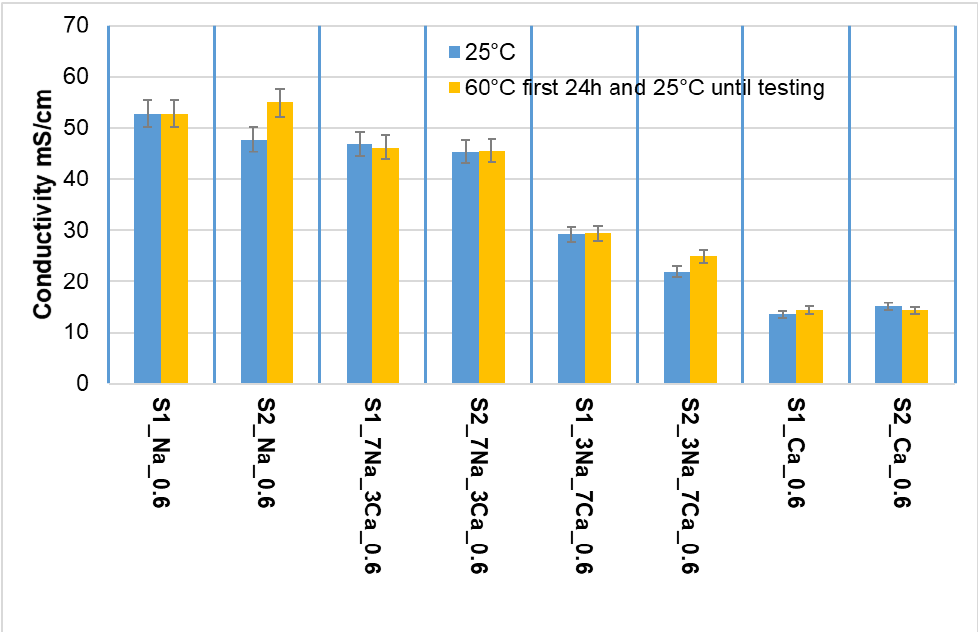
Figure 8. The electrical conductivity of the solutions resulting from the storage for 90 days in distilled water of G-AAIPs prepared with glass powders with different fineness (S1—2086 cm 2 /g and S2—2998 cm 2 /g) .